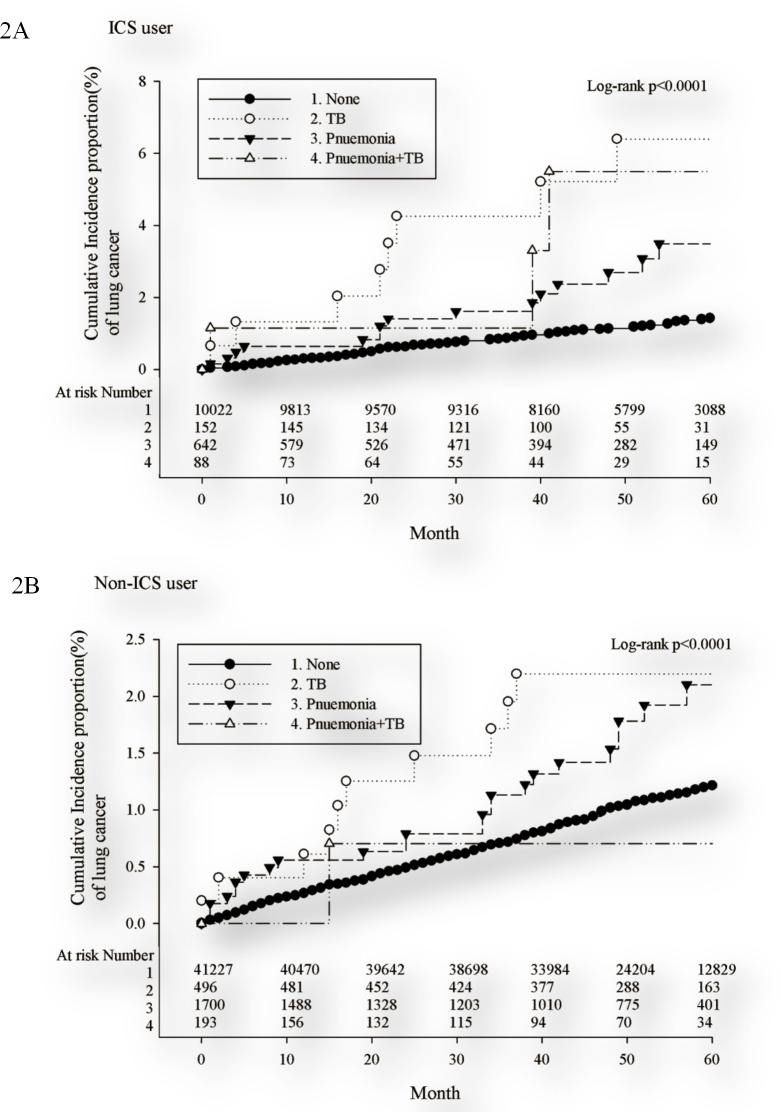
Cumulative incidence of lung cancer for ICS users (A) and the comparison cohorts (B) stratified by pulmonary diseases in Taiwan from 2003 to 2010. ICS, inhaled corticosteroid; TB, tuberculosis.